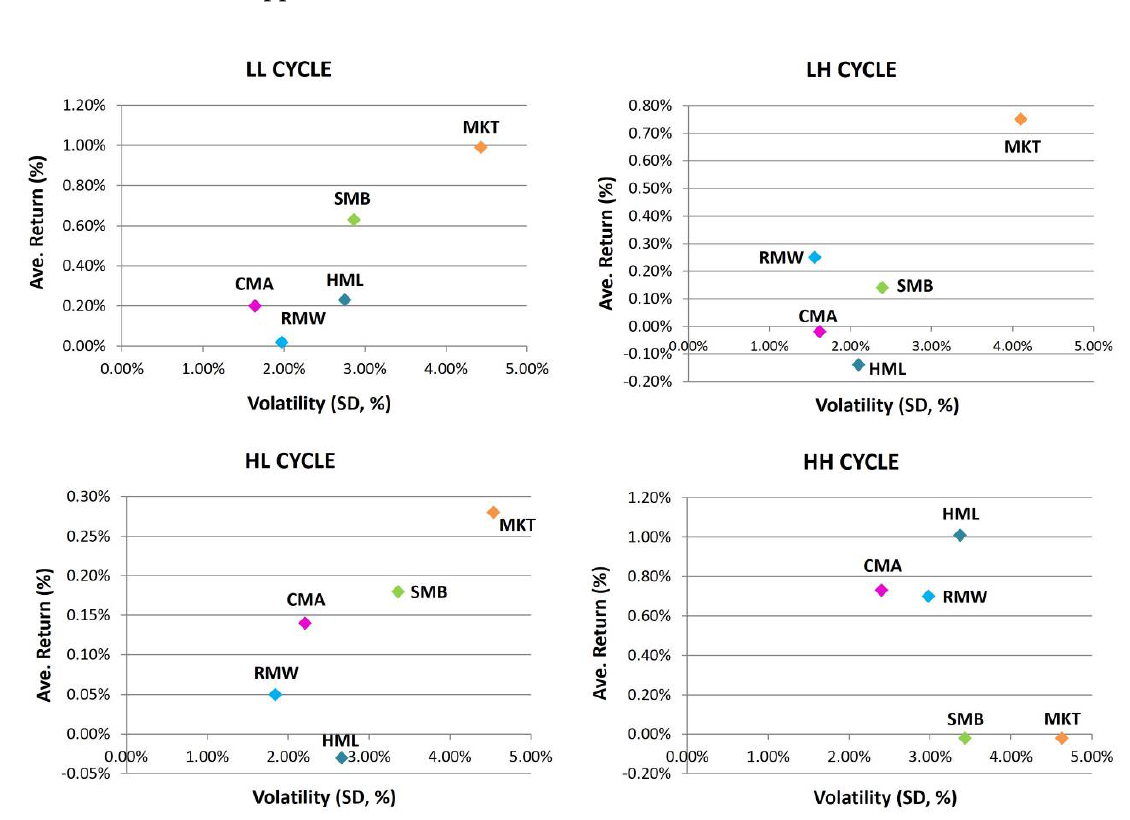
Figure A2. The risk-return relationship of the five factors in market cycles (1965–2018). LL, LH, HL, and HH denote the low-interest rate and low-sentiment, low-interest rate and high-sentiment, high-interest rate and low-sentiment, and high-interest rate and high-sentiment cycle, respectively.